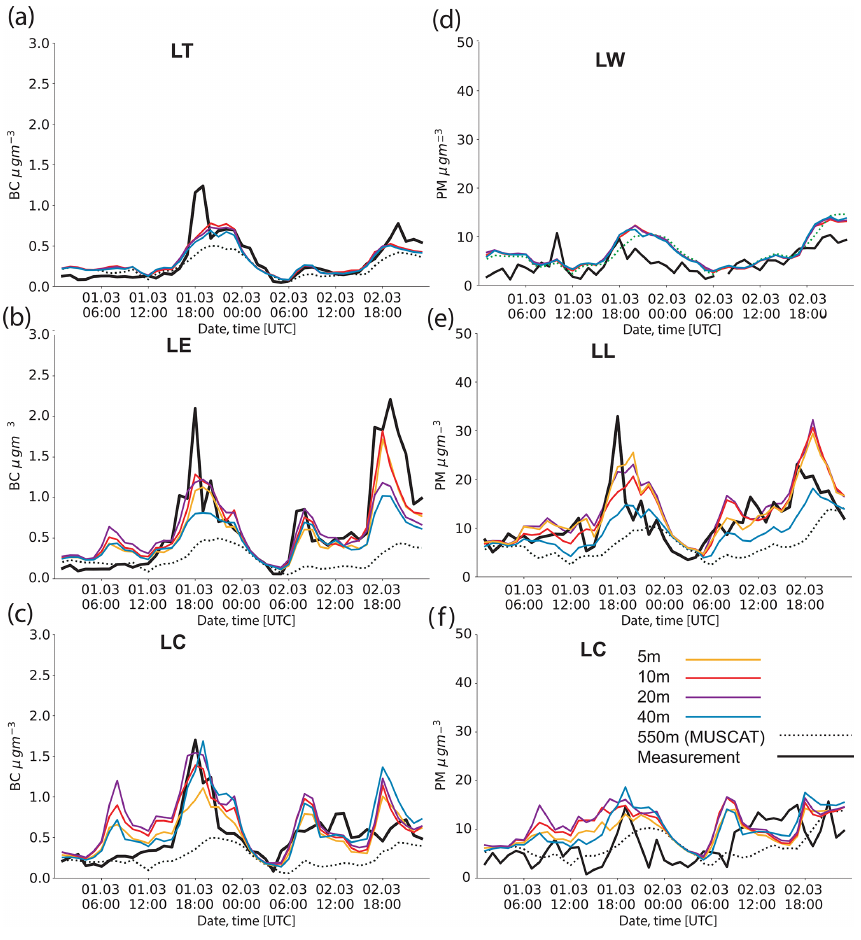
Figure 18. As Fig. 15, but showing the results of model sensitivity to the grid spacing. Compared are the nested CAIRDIO simulations with horizontal grid spacings of 40, 20, 10, and 5m, respectively, as well as the COSMO-MUSCAT simulation with 550m horizontal